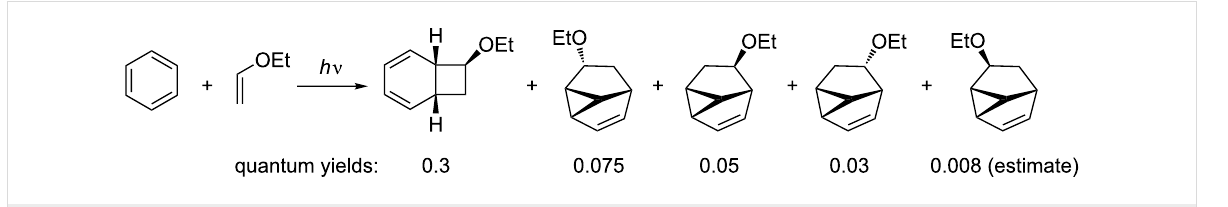
Scheme 4: Photocycloaddition shows lack of mode